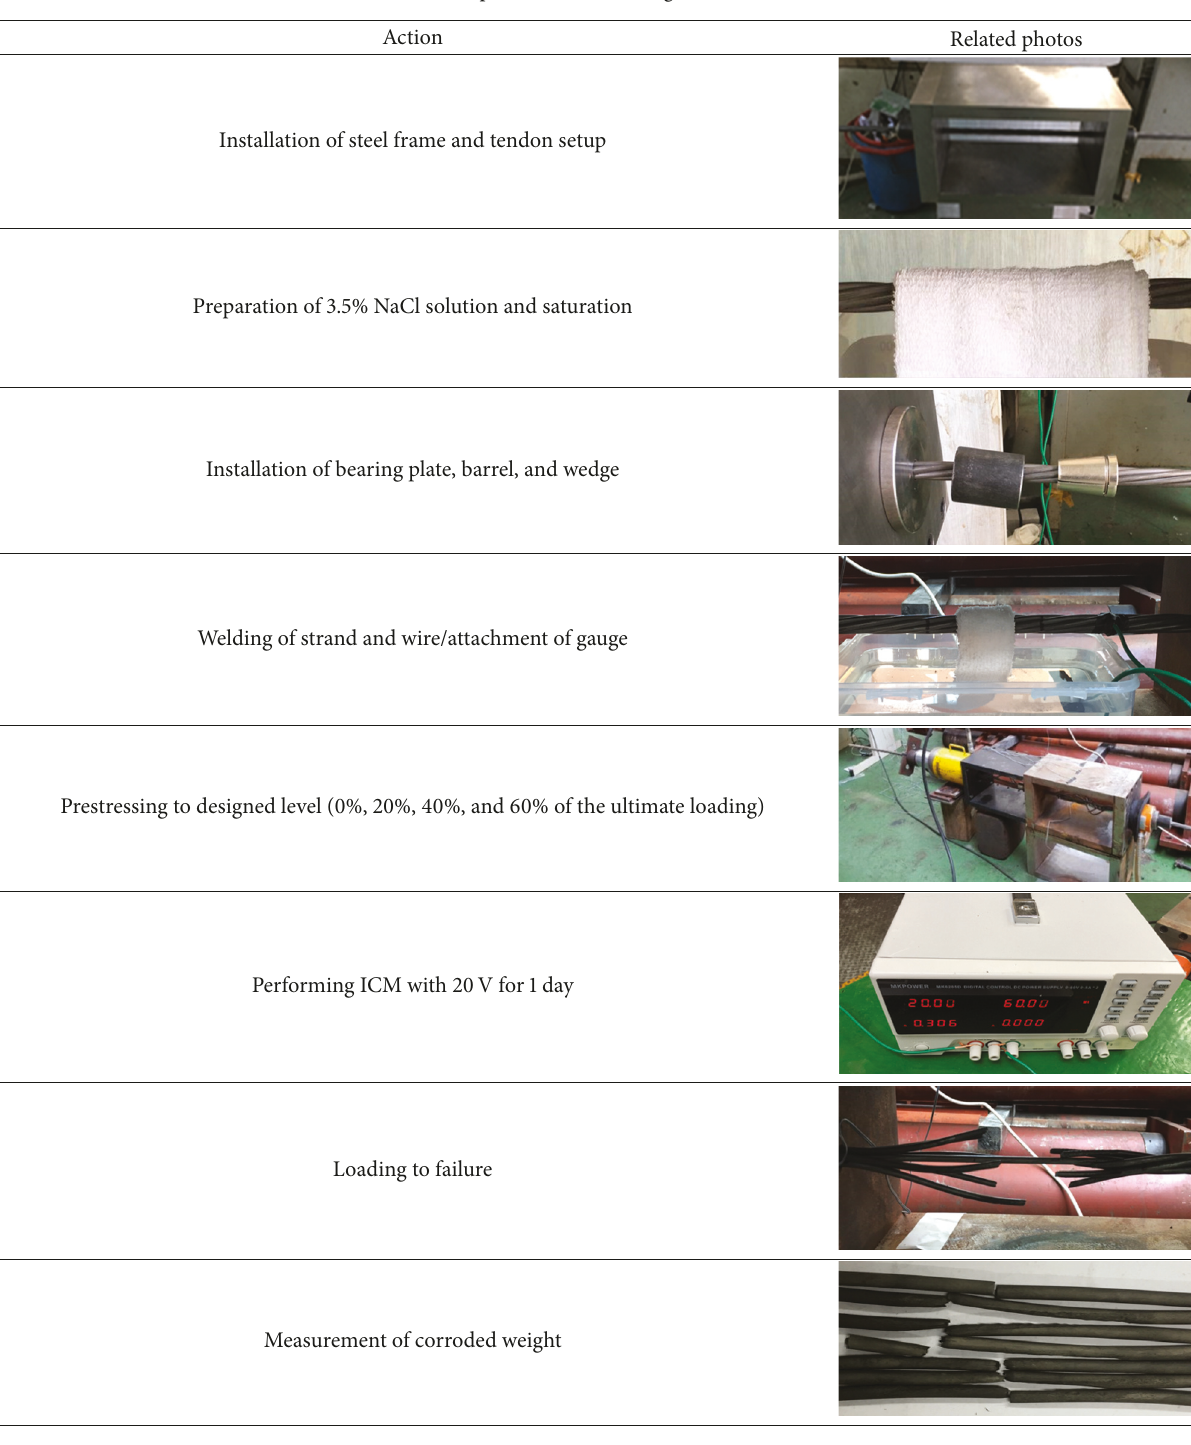
Table 1: The entire procedure for loading and corrosion